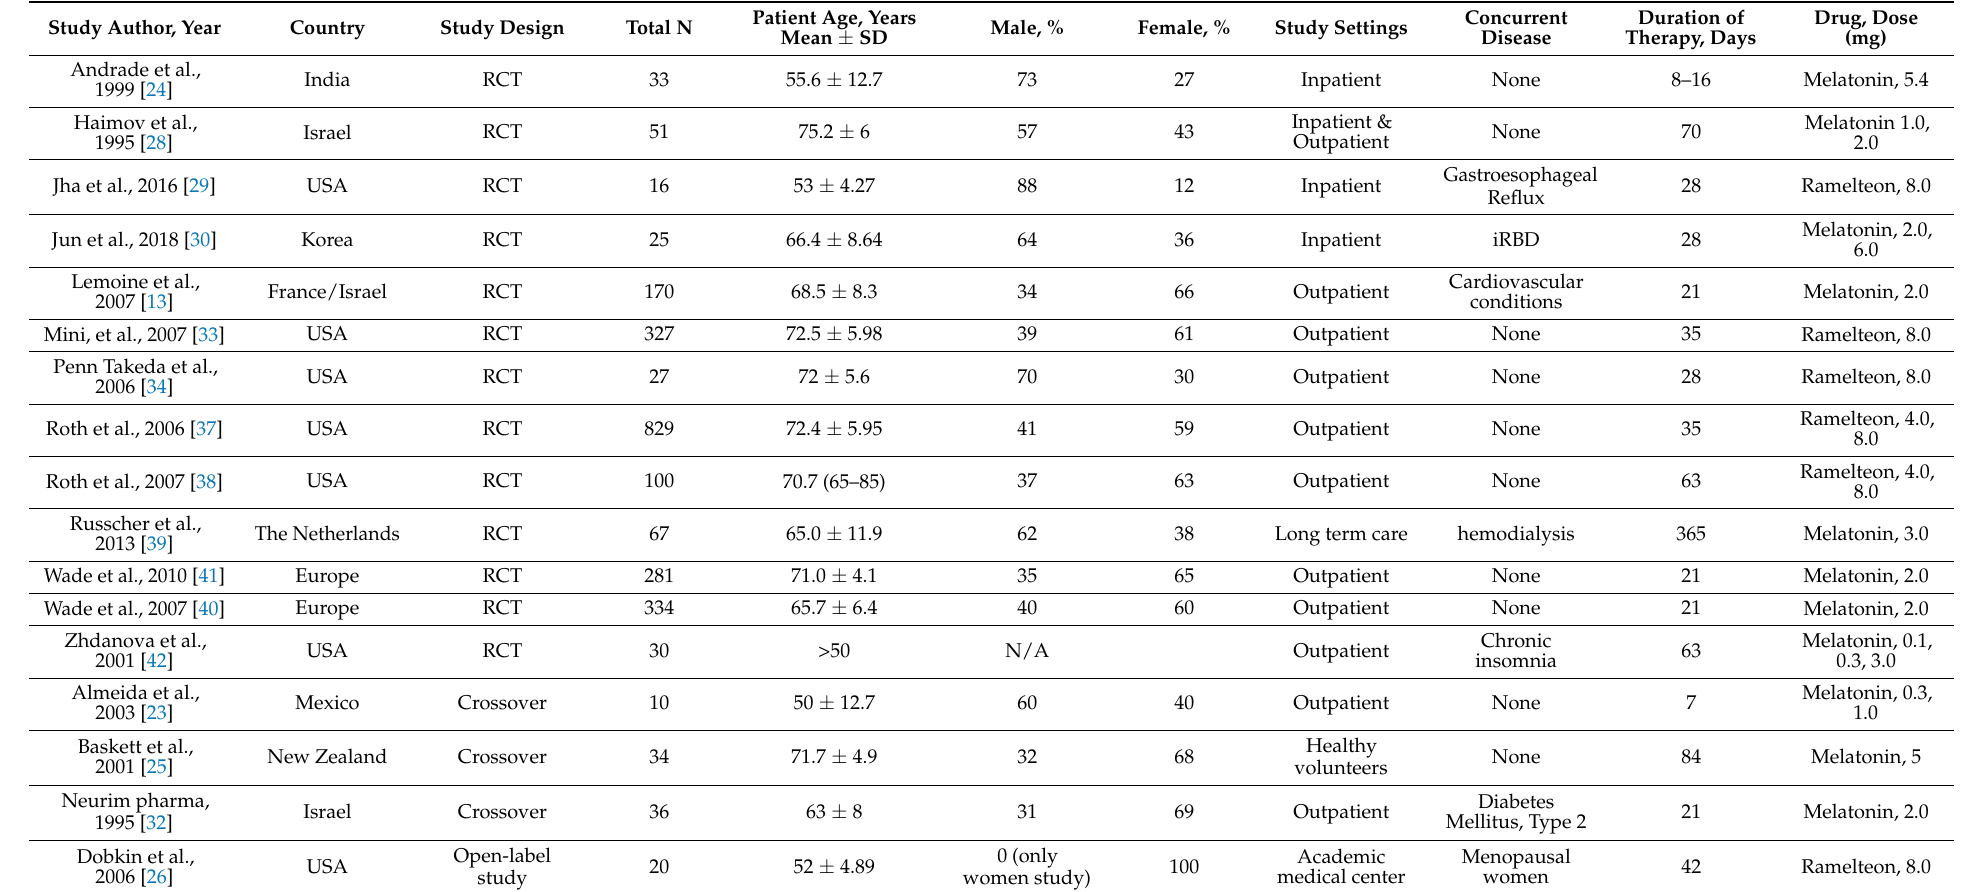
Table 1. Characteristics of the Included Studies in the systematic